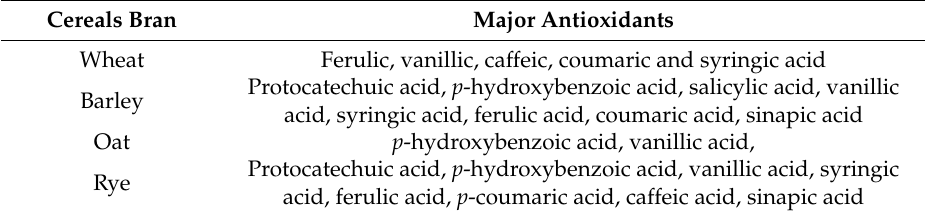
Table 6. Phenolic antioxidants of cereal bran (adapted from Nayak et al. (2015) [69]). Cereals Bran Major